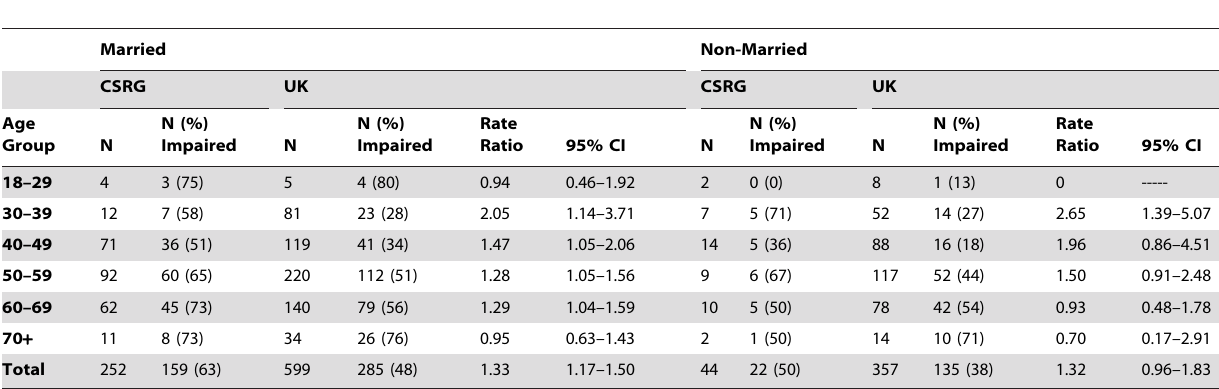
Table 3. Comparison of sexual impairment rates between women with systemic sclerosis and women from a UK general population sample, stratified by age and marital